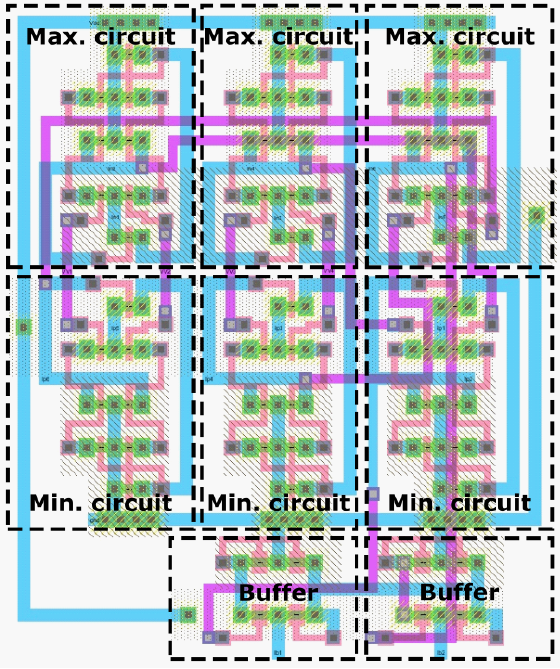
Figure 9. Layout of defective pixel correction